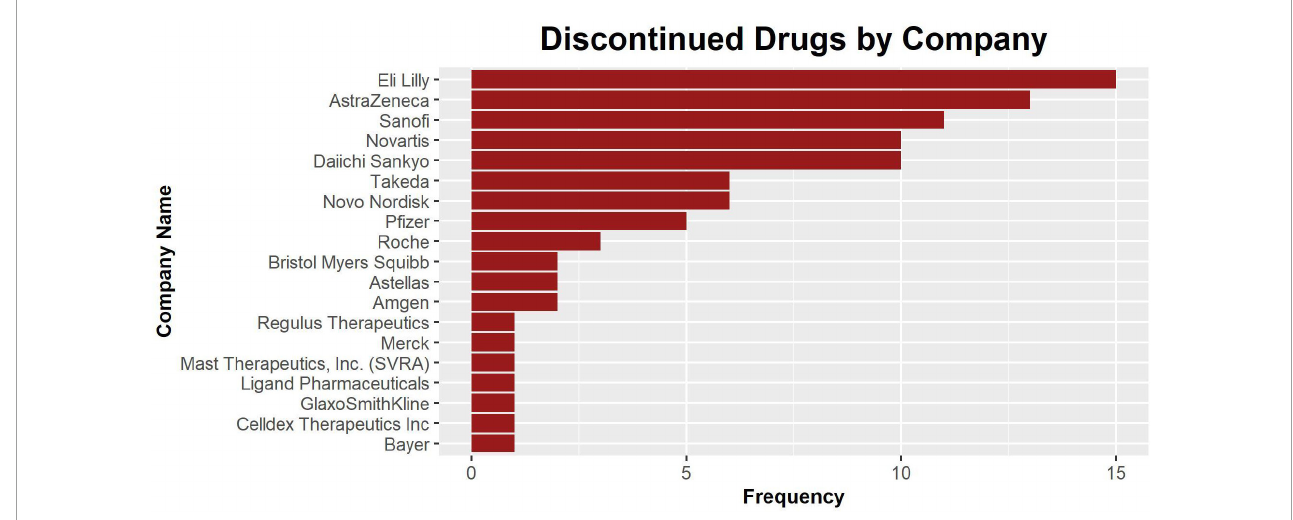
FIGURE5 The bar plot of discontinued drugs by company. The companies are listed in order of the number of drug assets recorded in this database. Nine companies have one recorded asset.